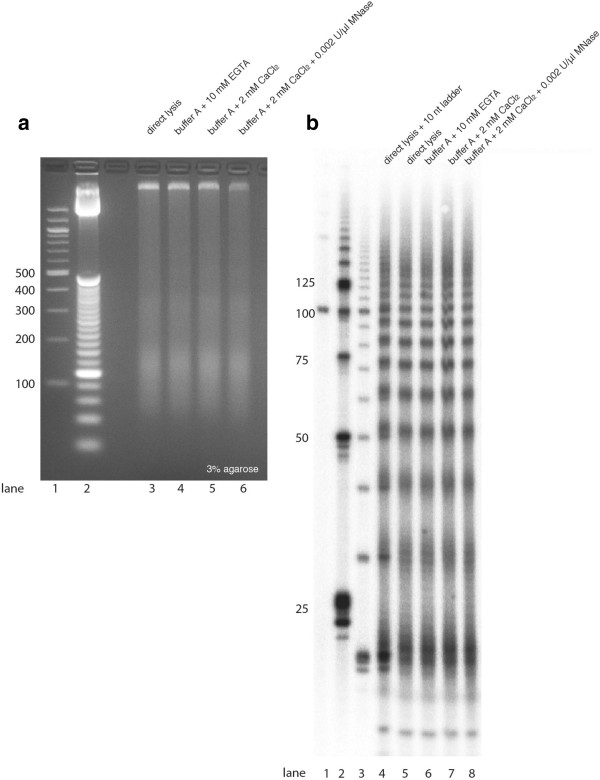
Fragmented chromatin in activated fer-1(b232) mutant oocytes. Genomic DNA extracted from fer-1(b232) oocytes was resolved on a 3% (native) agarose gel (a) or a denaturing 12% polyacrylamide gel (8 M urea) (b). For 'direct lysis’, frozen oocytes were ground in liquid nitrogen and directly mixed with worm lysis buffer without initial thawing (see Methods). For 'buffer A + 10 mM EGTA’, 'buffer A + 2 mM CaCl2’, or 'buffer A + 2 mM CaCl2 + 0.002 U/ul MNase’, ground oocytes were mixed with corresponding buffer, followed by incubation at 37°C for 2 minutes and DNA extraction. DNA samples in panel b were radioactively labeled at the 5′ end. For 'direct lysis + 10 nt ladder’, a mixture of fer-1(b232) oocyte DNA and 10 nt ladder was resolved in the same lane.